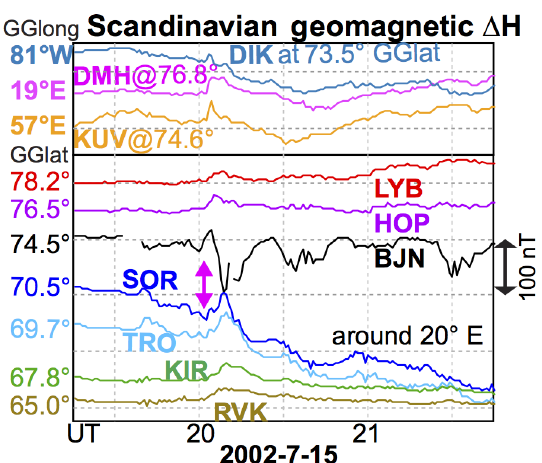
Figure 7. Geomagnetic (cid:49) H in northern Scandinavia and three other stations at around 75 ◦ GGlat (stations shown in Fig. 1; Kullorsuaq – KUV) for the X3.0 flare on 15 July 2002. DIK, DMH, and KUV values are approximated by the change in the local magnetic north direction. Red arrows denote the start of the X flare and subsolar crochet. At 20:00UT, all stations are under sunlight at the iono- sphere.